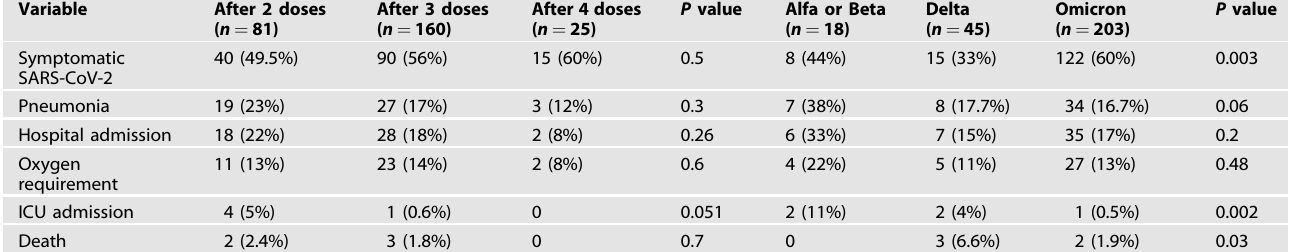
Table 6. Severity of SARS-CoV-2 infection according to the likelihood of SARS-CoV-2 variant and the timing of the infection with regards to the vaccine dose. Variable